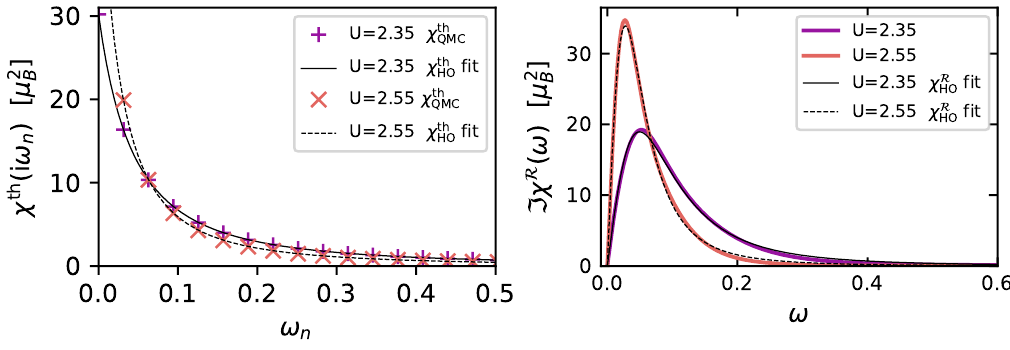
for the fit-parameters of Table 1. HO